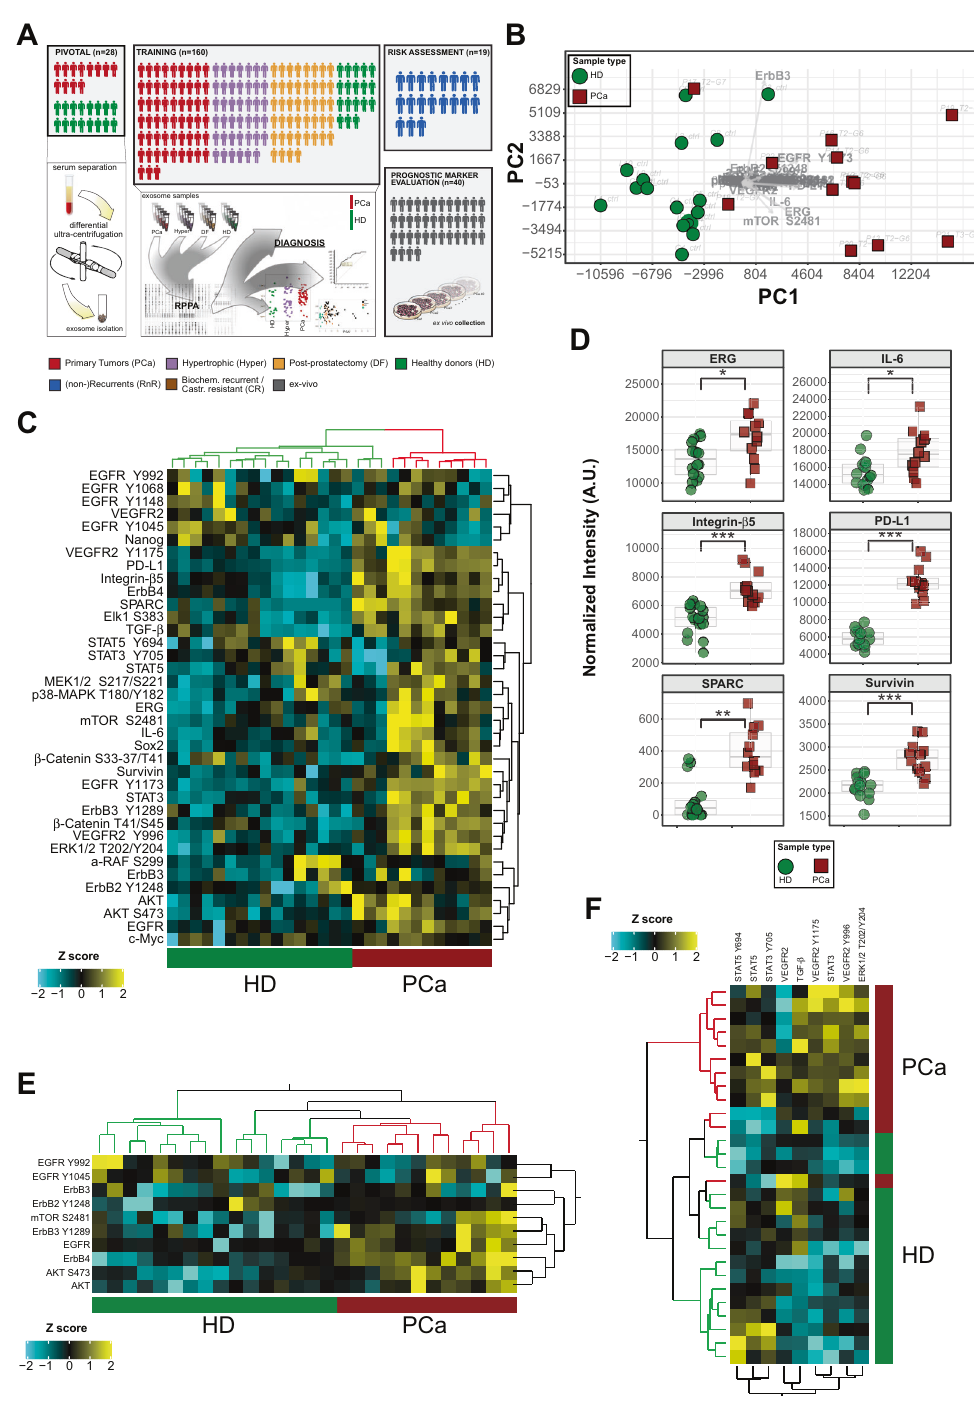
to infer sample origin (Fig. 3B and Fig. S5A). Hierarchical clustering of RPPA data con fi rmed that such EV-based proteomic analysis differentiates PCa from HD (Fig. 3C). In particular, ERG (ETS-related gene), PD-L1, Survivin, Integrin- β 5, IL-6 and SPARC were signi fi cantly altered in tumoral EVs (Fig. 3D). Prospectively, RPPA analysis of key EV (phospho-) proteins such as those involved in the EGFR, mechanistic target of rapamycin (mTOR) and vascular endothelial growth factor receptor (VEGFR) pathways, allow cancer- and patient-speci fi c adoption of treatment strategies (Fig. 3E,